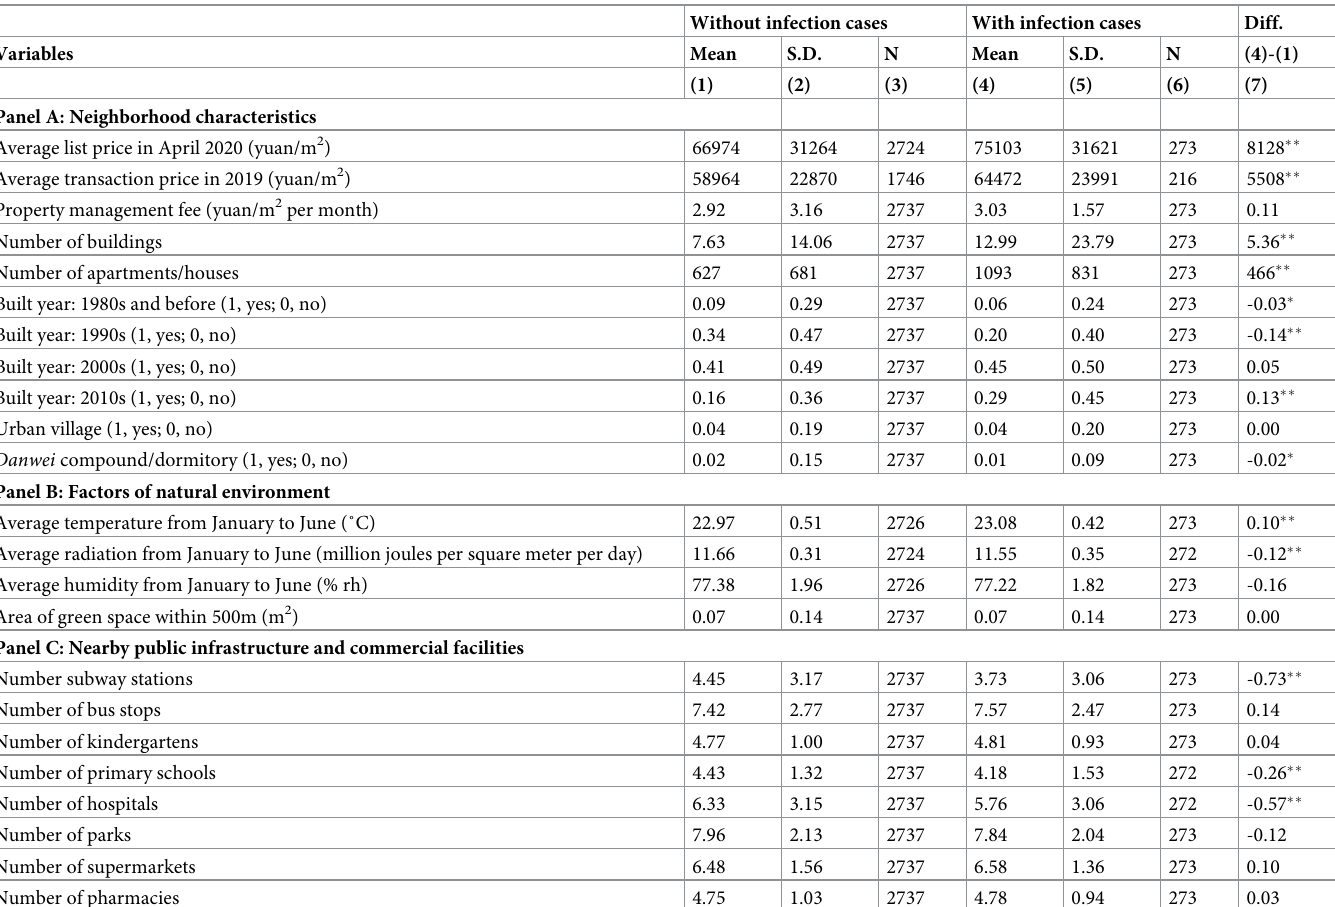
Table 1. Summary statistics: Neighborhoods with and without COVID-19